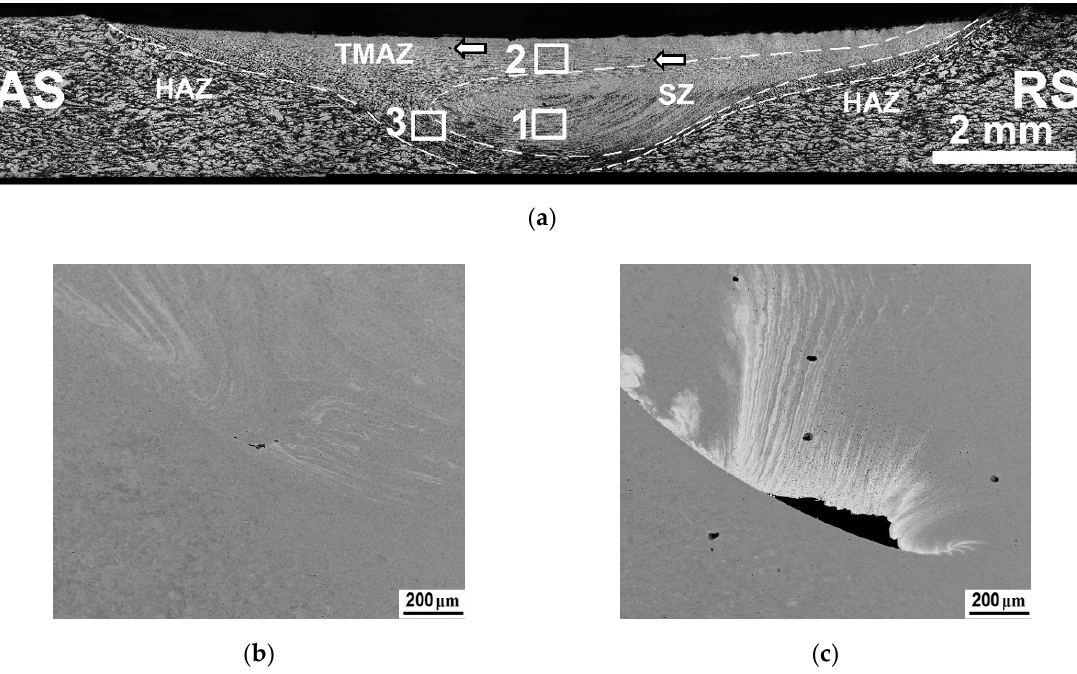
Figure 3. Cross-section of the weld in the 400-50 specimen ( a ); imperfections of the 600-100 ( b ) or 1000-100 ( c ) specimens in the area which approximately corresponded to the box #3 in ( a ). #1 box was located 0.3 mm below the upper surface of the specimen, and #2 box was located 1.3 mm below.